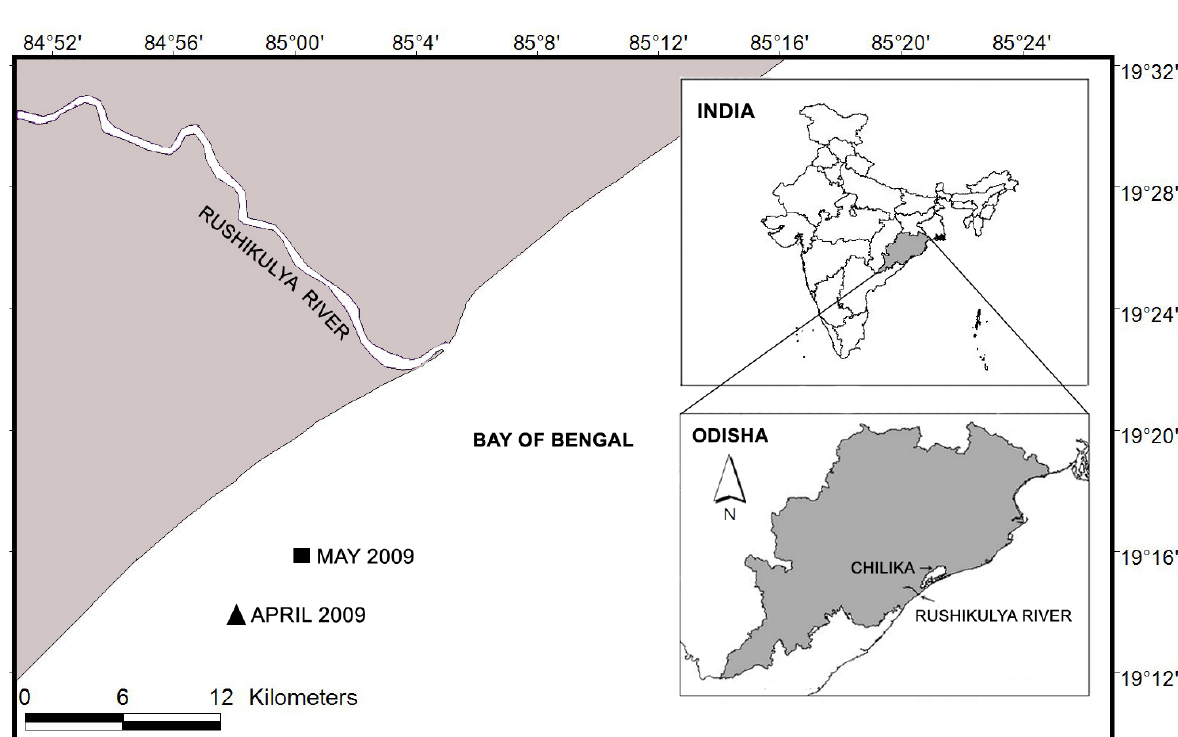
Image 1. Map of the Odisha coast showing the Rushikulya River and whale sighting